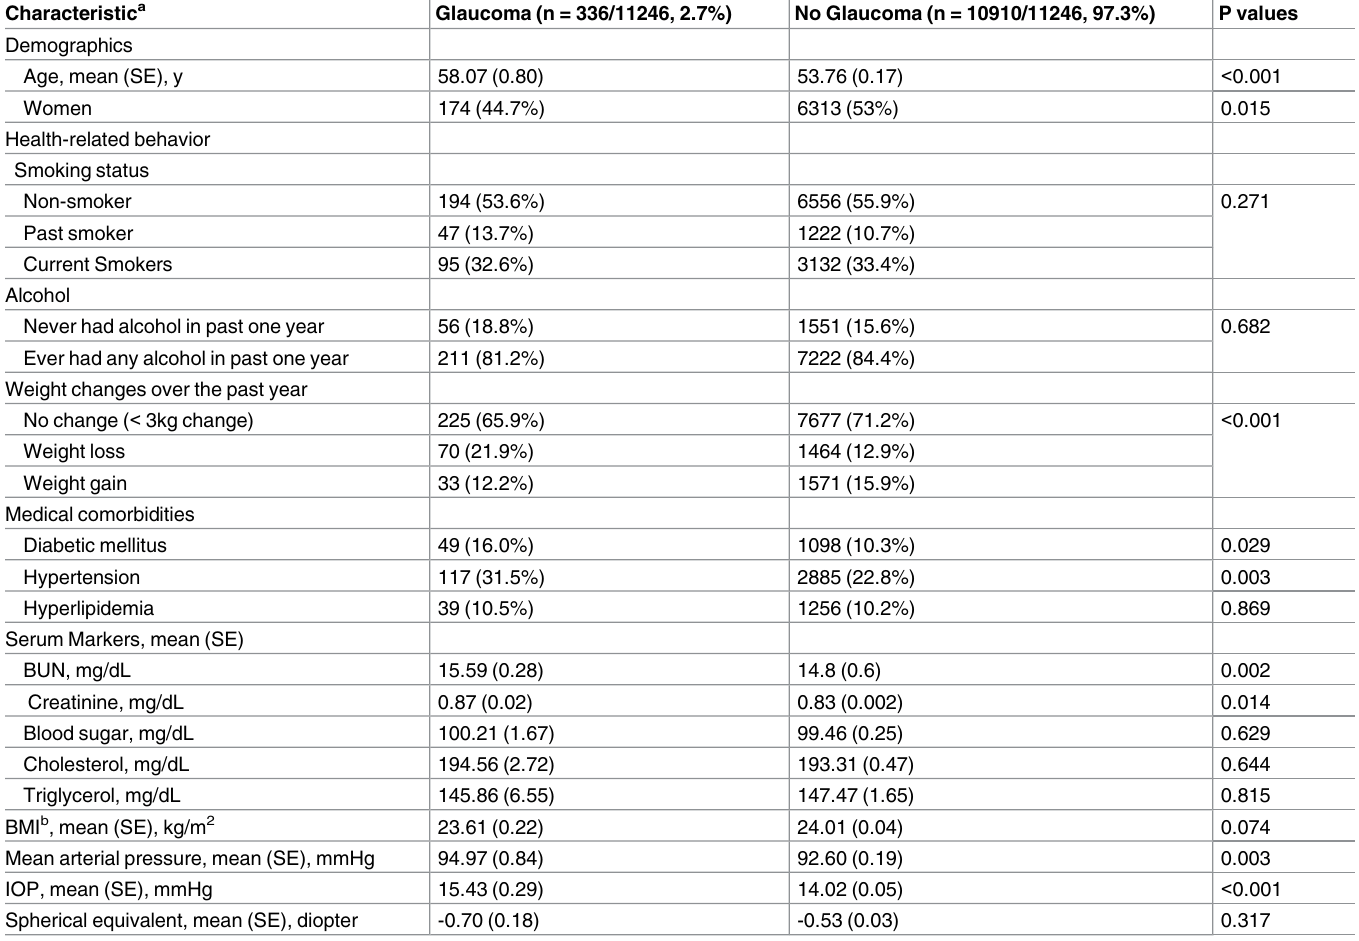
Table 1. Demographic and general health characteristics of participants with and without glaucoma.